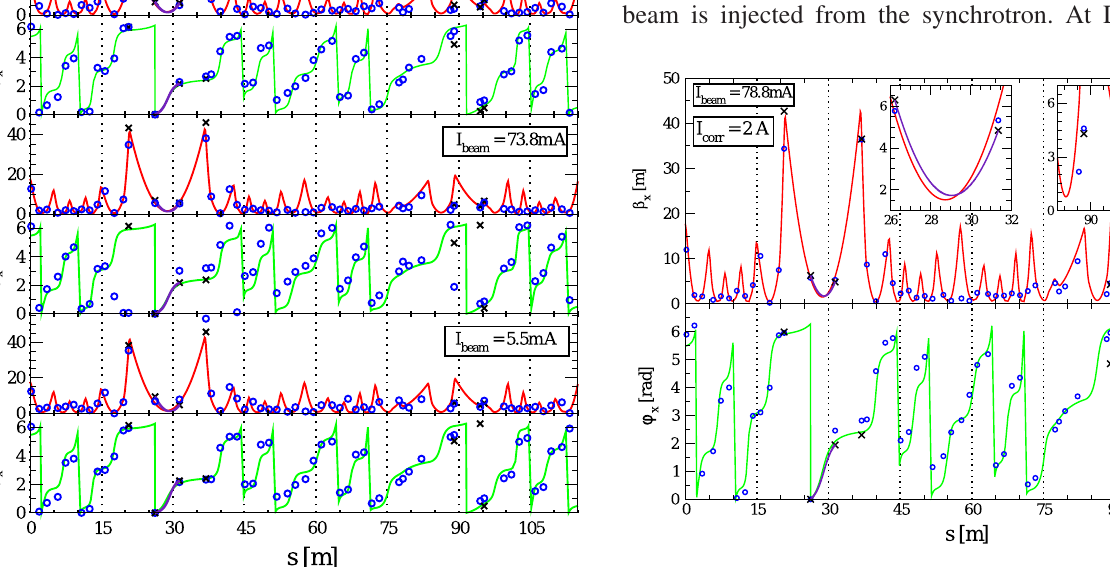
FIG. 4. Same measurement as in Fig. 3 with I corr ¼ 0 : 5 A .